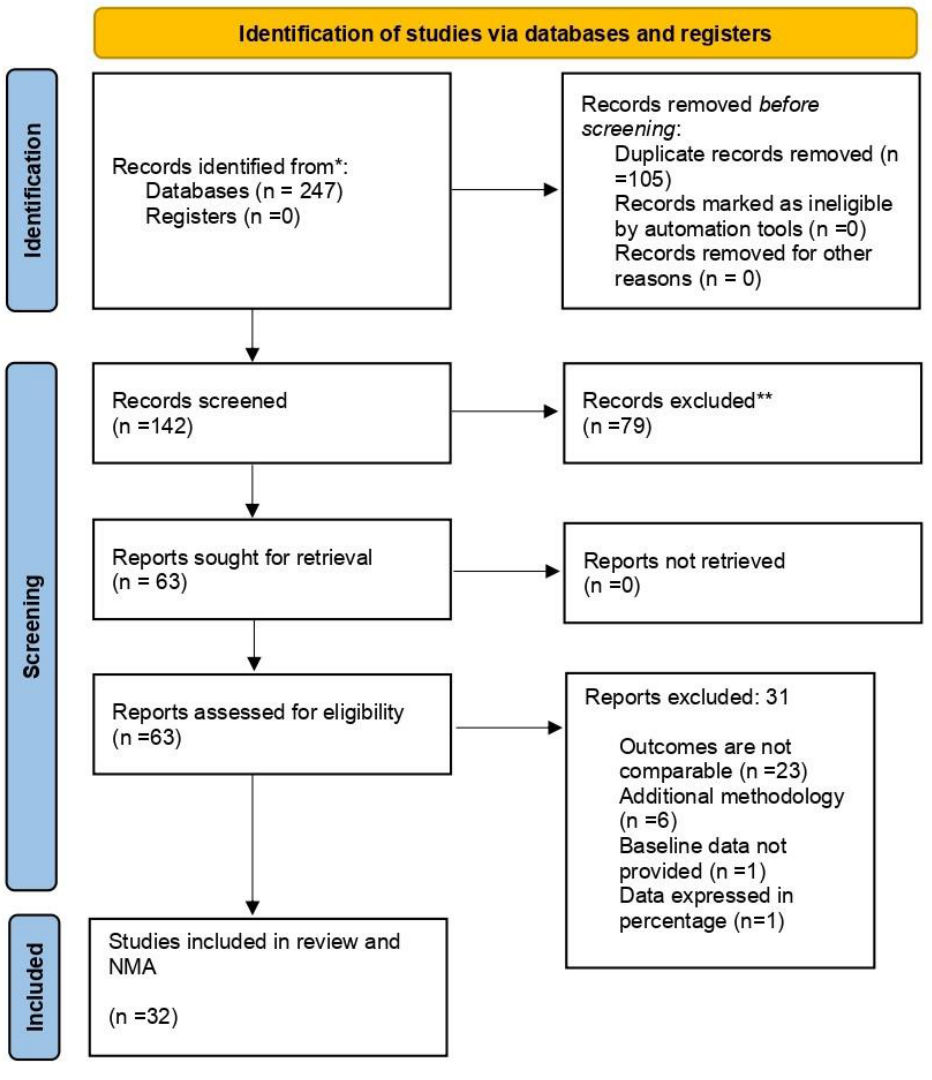
Figure 1. Prisma Flow